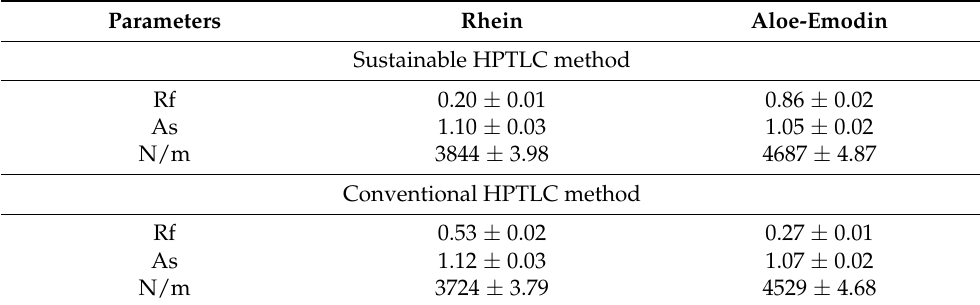
Table 2. System suitability parameters of rhein and aloe-emodin for the sustainable and conventional analytical methods (mean ± SD; n = 3).